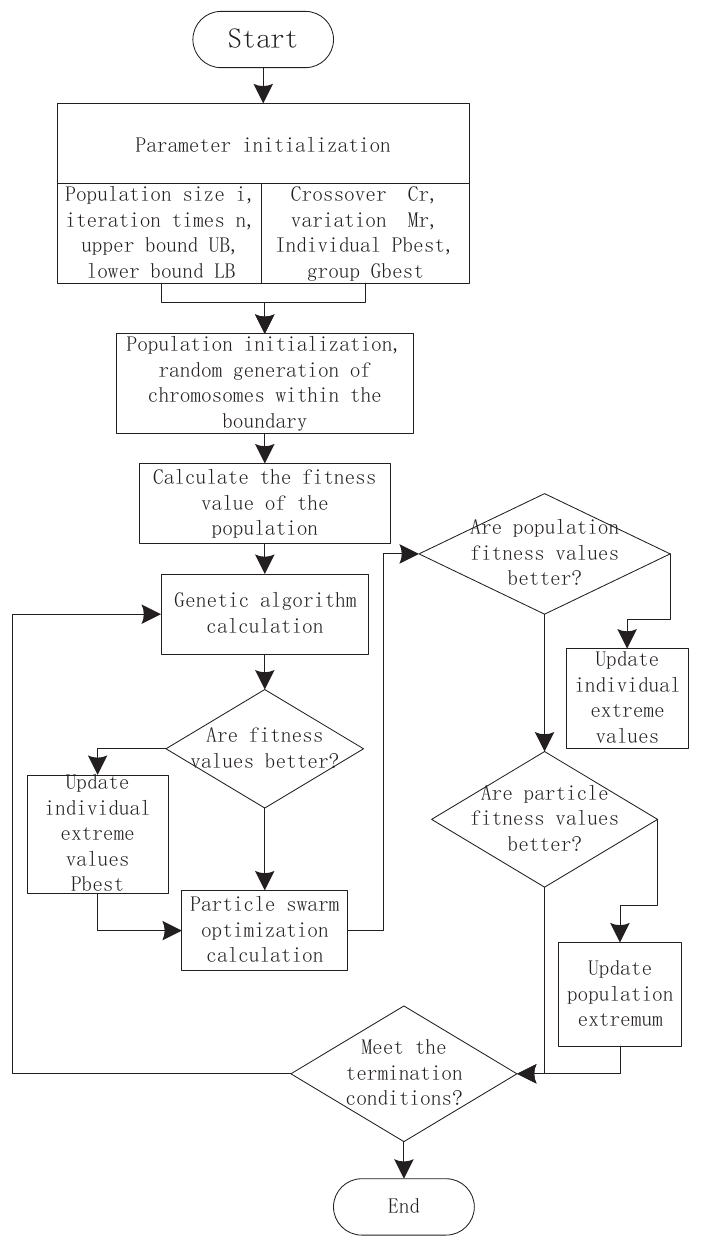
Figure 4. Mine water optimization flow chart based on hybrid